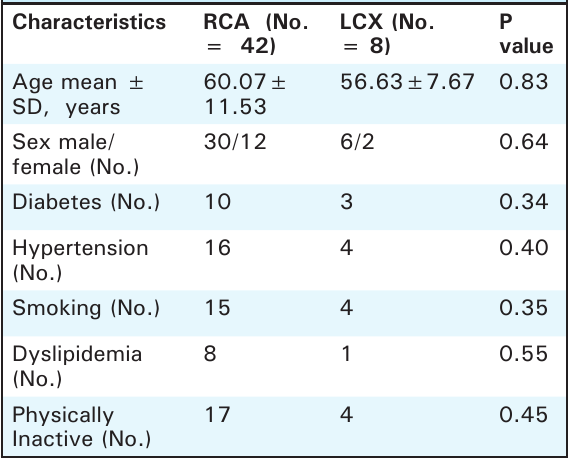
Table 3. Comparison of baseline characteristics in relation to RCA Vs. LCX. Characteristics